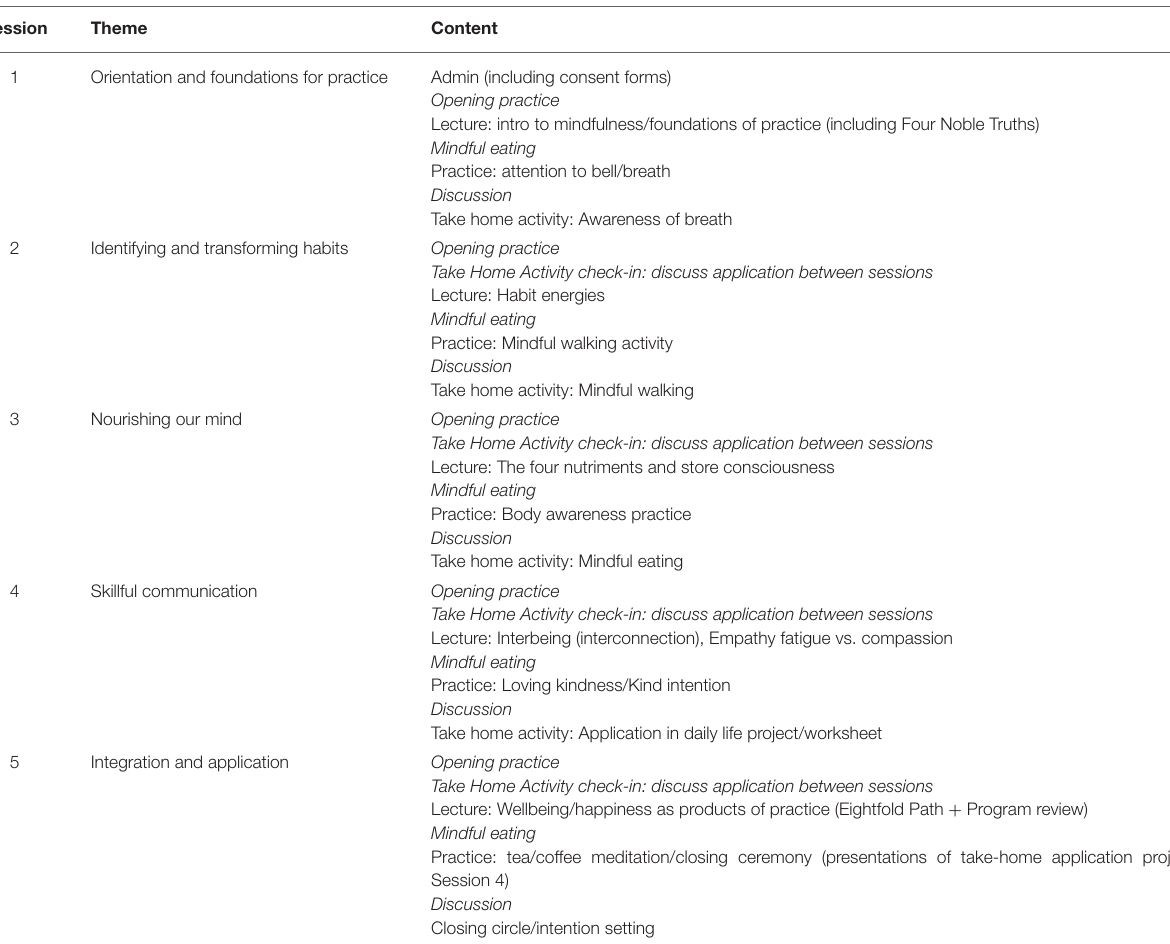
TABLE 2 | AMP-MP weekly themes and content.